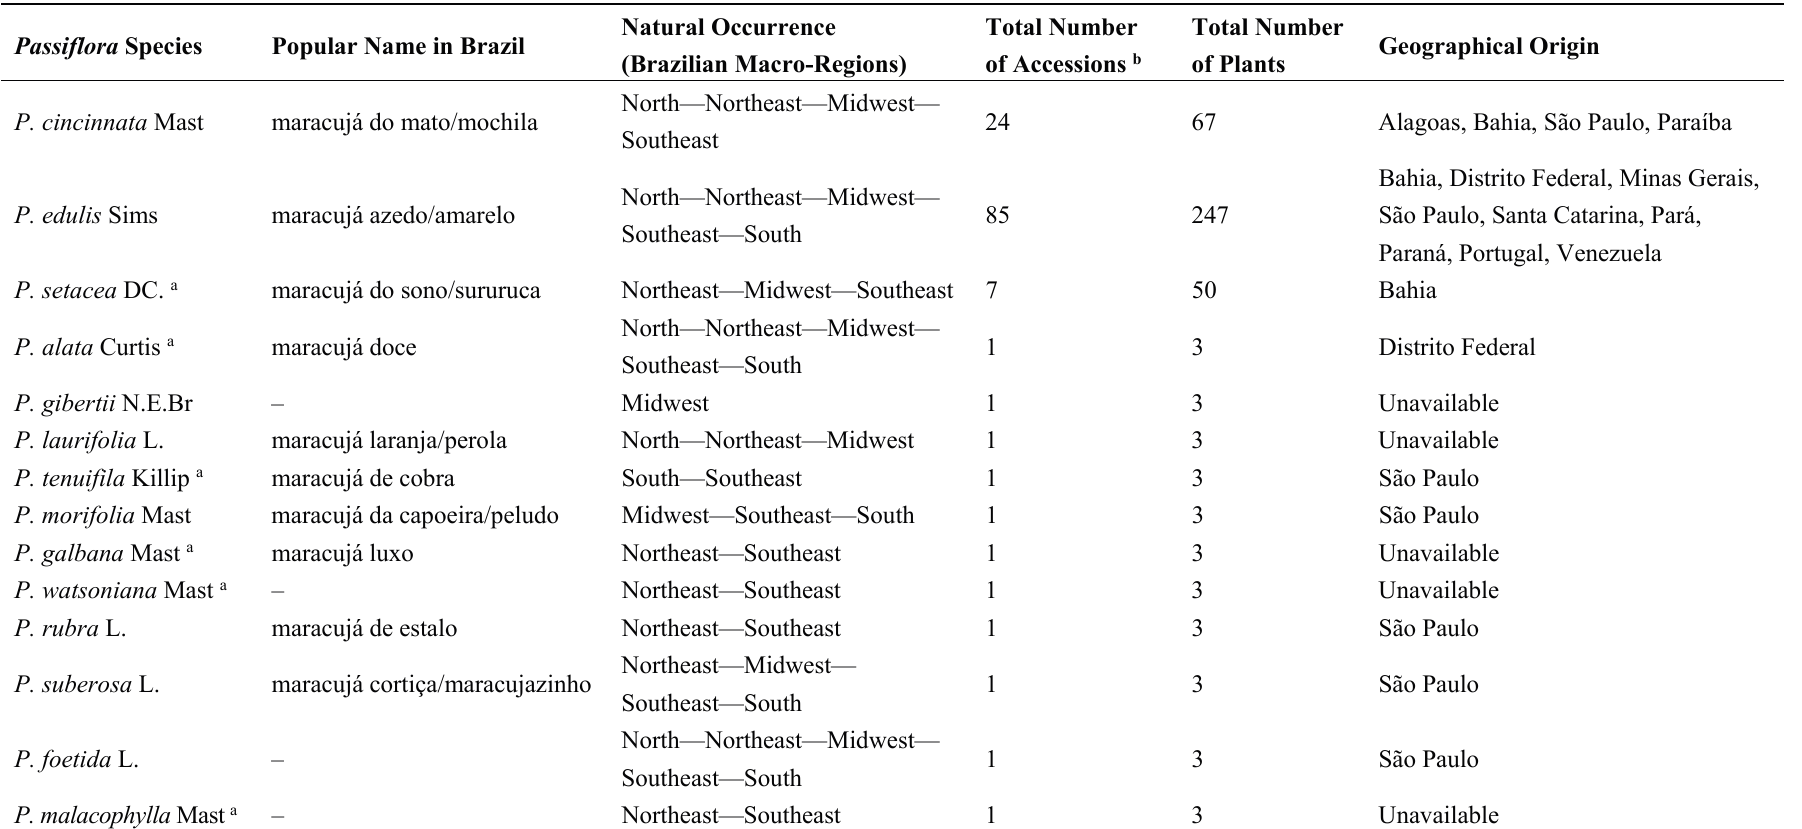
Table 4. General information about the 14 passion fruit species characterized in this study. Passiflora Species Popular Name in